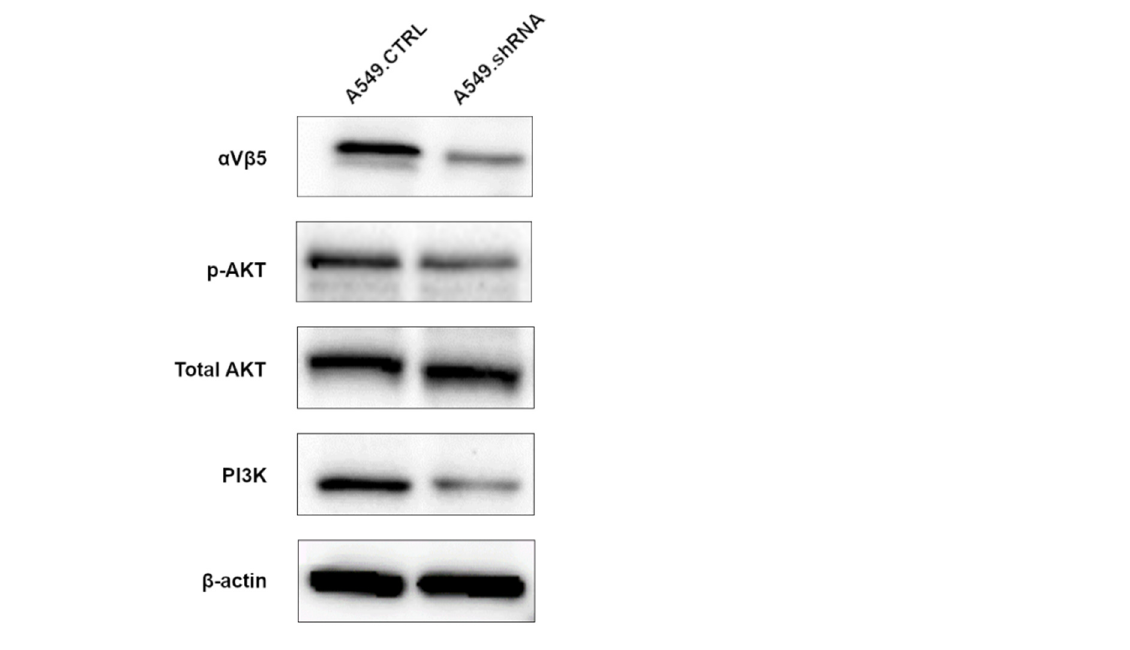
Figure 11. Effects of periostin (POSTN) silencing on integrin-signaling-pathway-related protein. Western blotting assay was performed to detect integrin- α v β 3, p-AKT, total AKT, and PI3K in A549.shRNA cells compared to A549.CTRL cells. β -actin protein was used as loading controls.